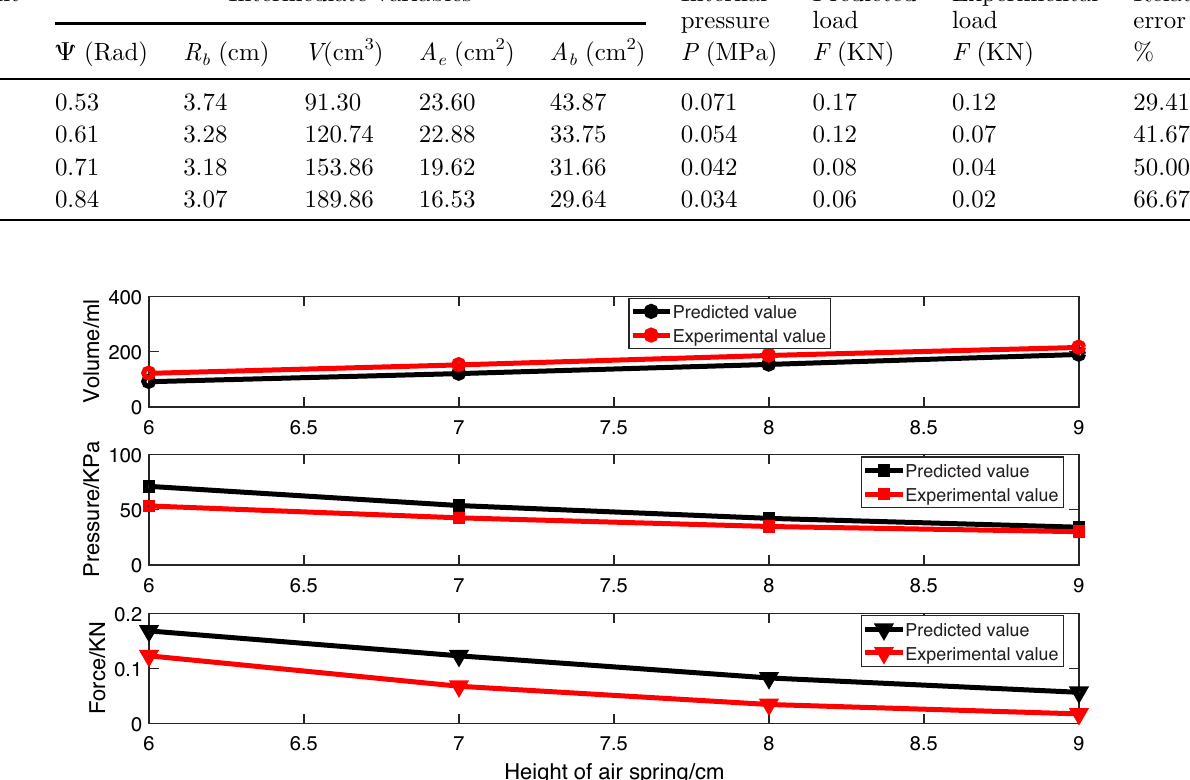
Fig. 12. Predicted and experimental